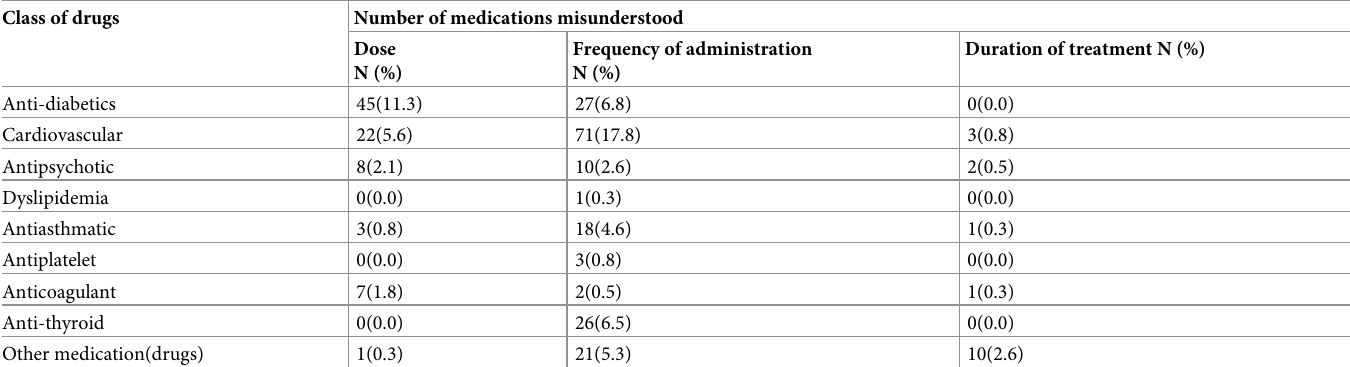
Table 4. Distribution of misunderstood medications by study participants for dosage regimen instructions.